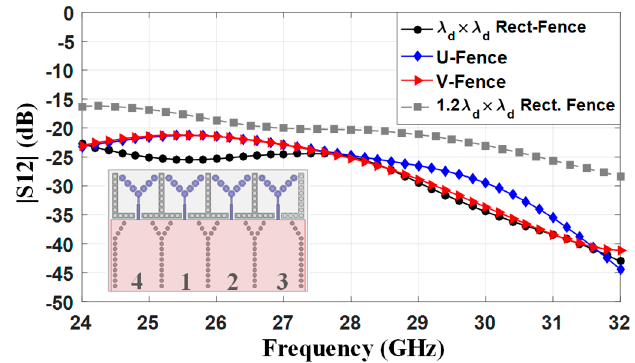
Figure 6. The simulated |S12| of the adjacent dipole array elements for the different fence shapes.